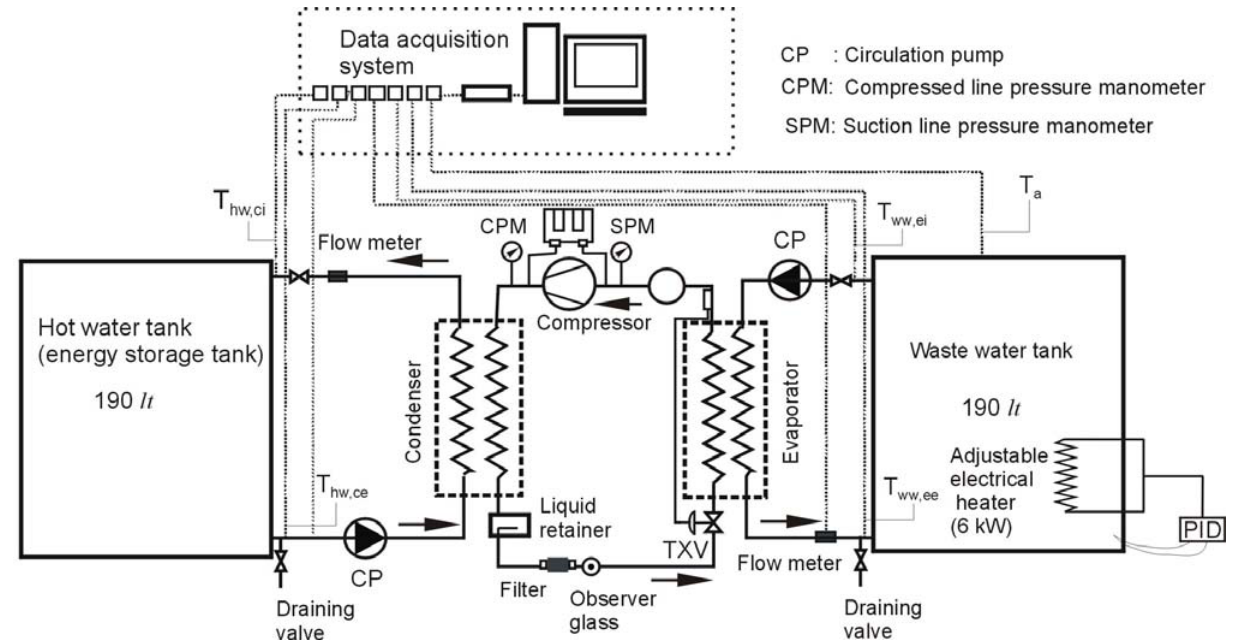
Figure 1. Schematic diagram of experimental rig of the heat pump